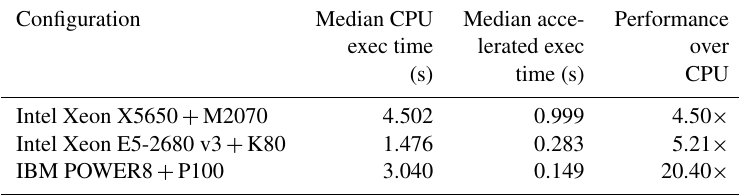
Table 3. Median execution time and achieved speed-up for the non-accelerated (CPU-only) code on a single core and the accelerated version of the kernel for the three platforms. The extracted execution timing results are for the time step after the initialization of the simulation.